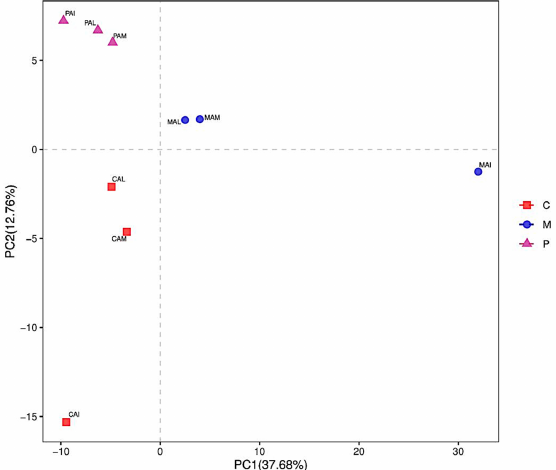
Figure 9. Discriminant analysis of partial least squares based on OUT. CAI is the pre-fermentation Cabernet Sauvignon, CAM is the mid-fermentation Cabernet Sauvignon, and CAL is the late fer- mentation Cabernet Sauvignon. MAI is the pre-fermentation Matheran, MAM is the mid-fermenta- tion Matheran, and MAL is the late fermentation Matheran. PAI is the pre-fermentation Cabernet Franc, PAM is the mid-fermentation Cabernet Franc, and PAL is the late fermentation Cabernet Franc.